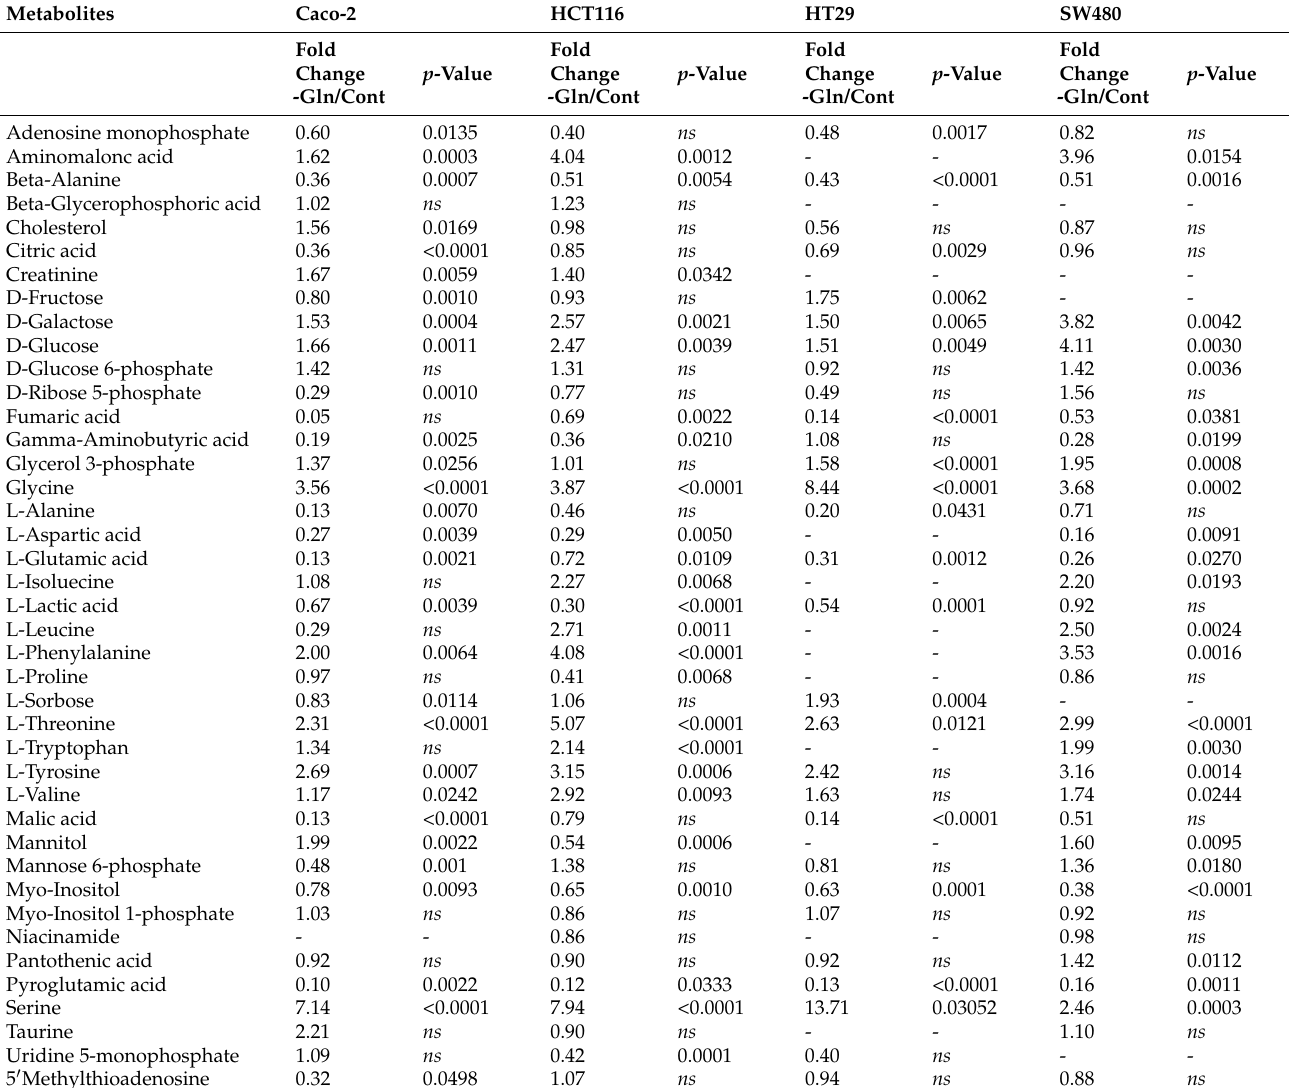
Table 5. Statistical parameters of metabolites detected with GC-MS analysis after 48 h of glutamine